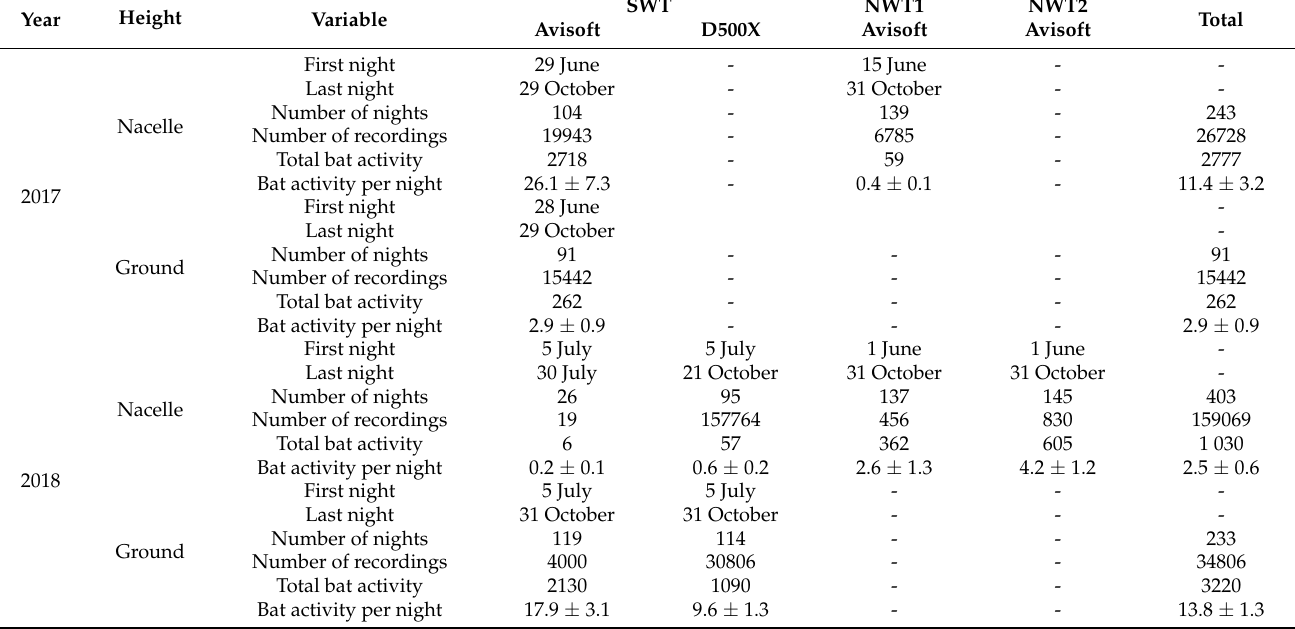
Table 1. Summary of the sampling results concerning the bat recording. The first and last night represent the first and last date respectively when the equipment worked. Number of nights represents the number of nights where the equipment worked. Number of recordings represent the total number of recording during the study period. Total bat activity represents the number of bat passes for the all study period. Bat activity per night is the mean (number of bat passes) ± SE per night. Note that the data from SWT, 2018, at the nacelle were not used for the analyses due to the low number of nights where the recorder